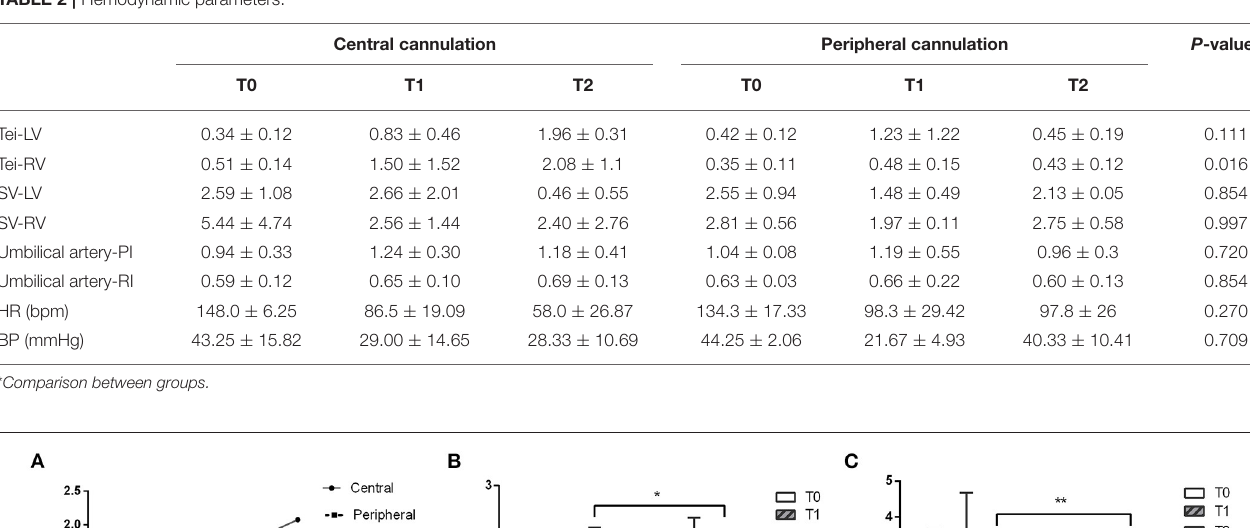
TABLE 2 | Hemodynamic parameters.